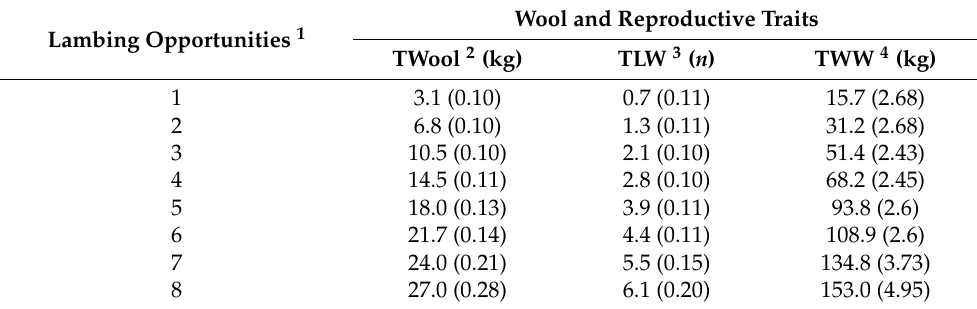
Table 5. Least square means (LSMs) and standard errors of the mean (SEMs) of accumulative total wool production (TWool, kg), total number of lambs weaned (TLW, n ), and total lamb live weight at weaning (TWW, kg) by lambing opportunity (1999–2020).